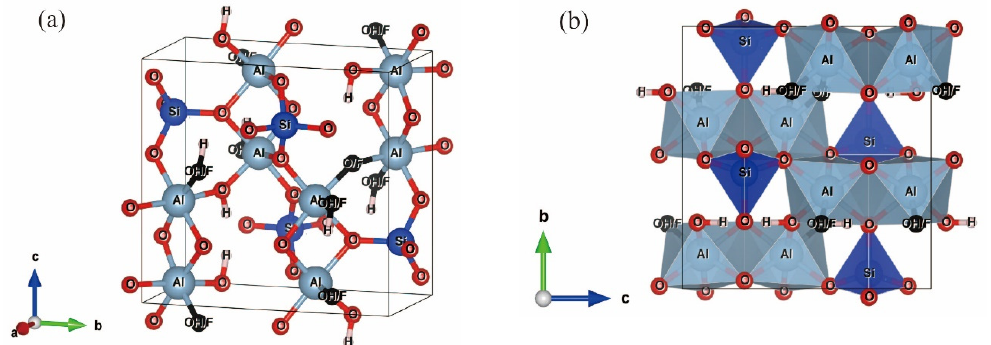
Figure 1. Crystal structure of topaz at ambient conditions with the style of ball-and-stick ( a ) and the style of polyhedron ( b ). Light blue for aluminum, dark blue for silicon, red for oxygen, light red for hydrogen, and black for fluorine instead of oxygen or hydroxide. The crystal structure data are obtained from Gatta et al. (2006) [30] .